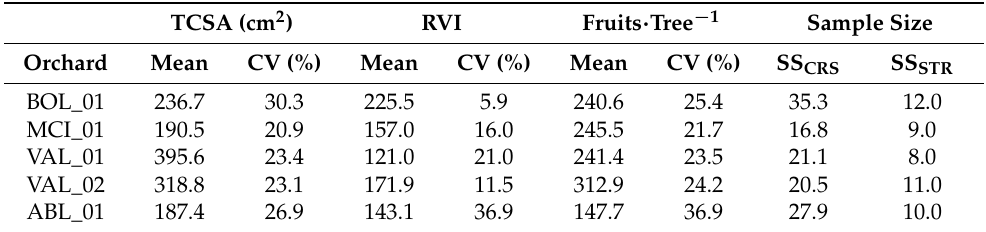
Table 2. Descriptive statistics (means and coefficient of variation, CV) for the characteristics measured in the trees of the sampling grids and sample sized used on complete randomized samples (SS CRS ) and stratified samples (SS STR